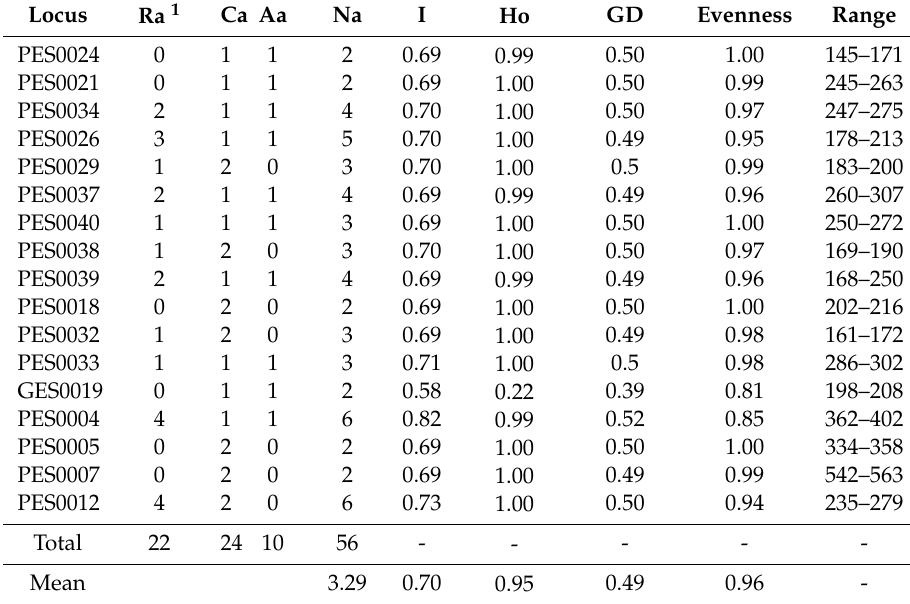
Statistics of genetic diversity across 17 simple sequence repeat (SSR) loci in 1109 ginseng